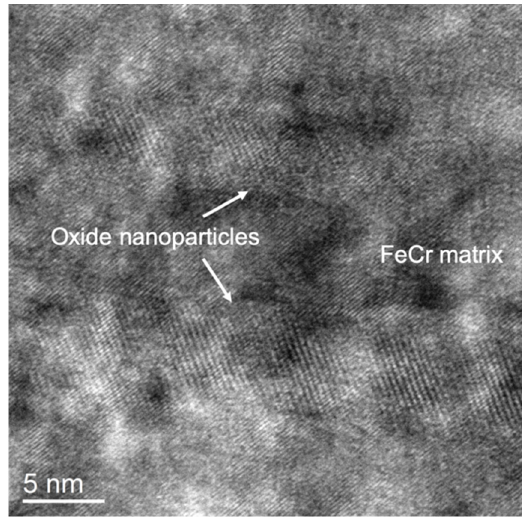
Figure 3. HRTEM picture of precipitates synthesized by Ti  Y  O implantations into FeCr fol- lowed by annealing at 800 °C for two hours. by annealing at 800 ◦ C for two